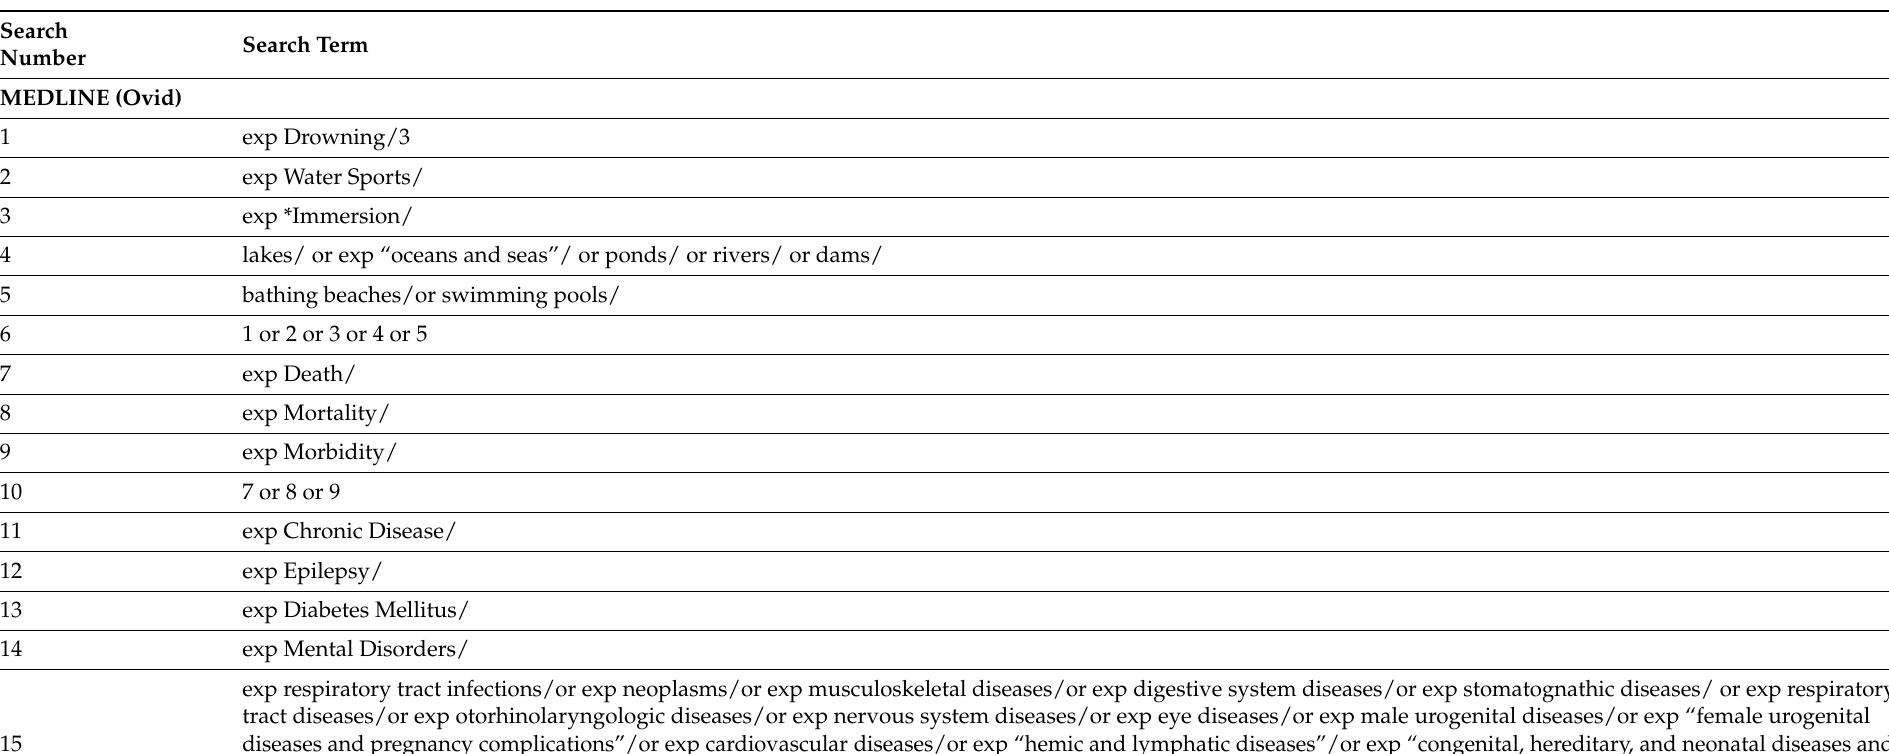
Table A1. Databases and Search Terms